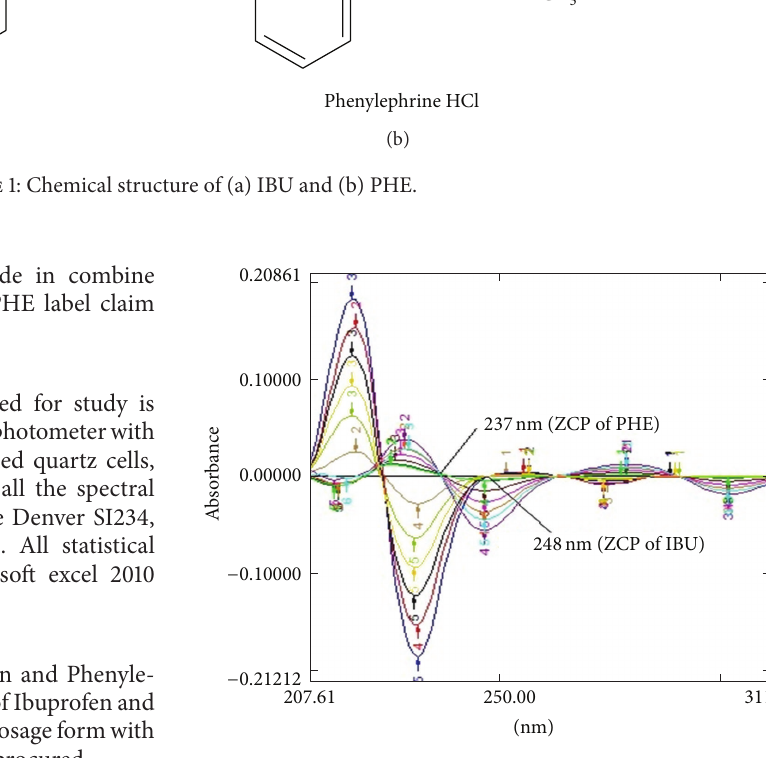
Figure 2: Overlain D 1 spectrum of IBU (12–72 ppm) and PHE (1.5– 22 ppm) in 0.1N